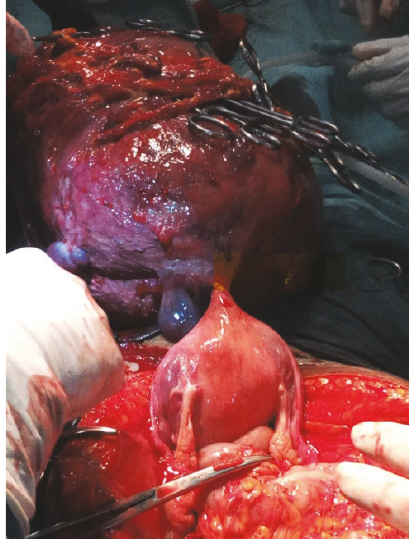
Figure 3: Intraoperative finding of a huge parasitic fibroid wrapped around and deriving its blood supply from the